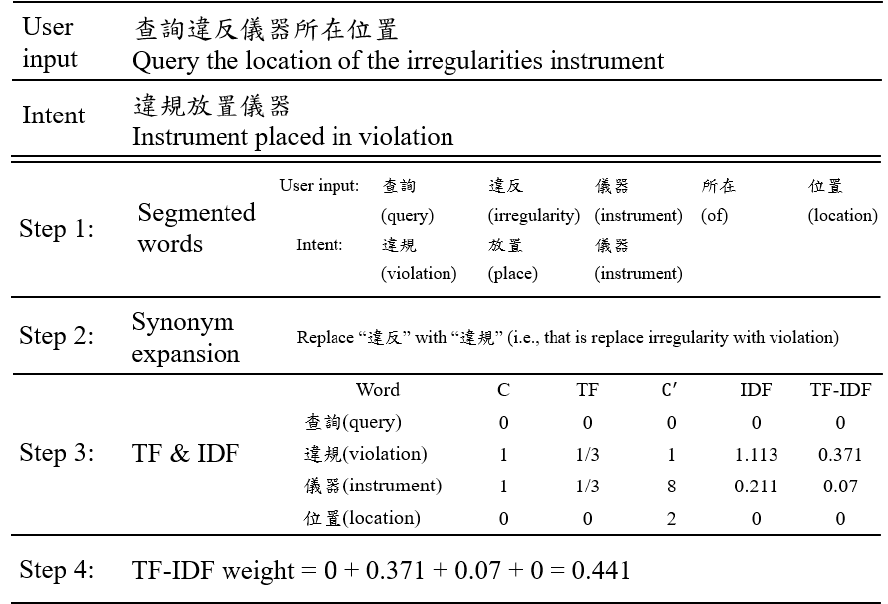
Figure 5. Example of term frequency–inverse document frequency (TF-IDF).